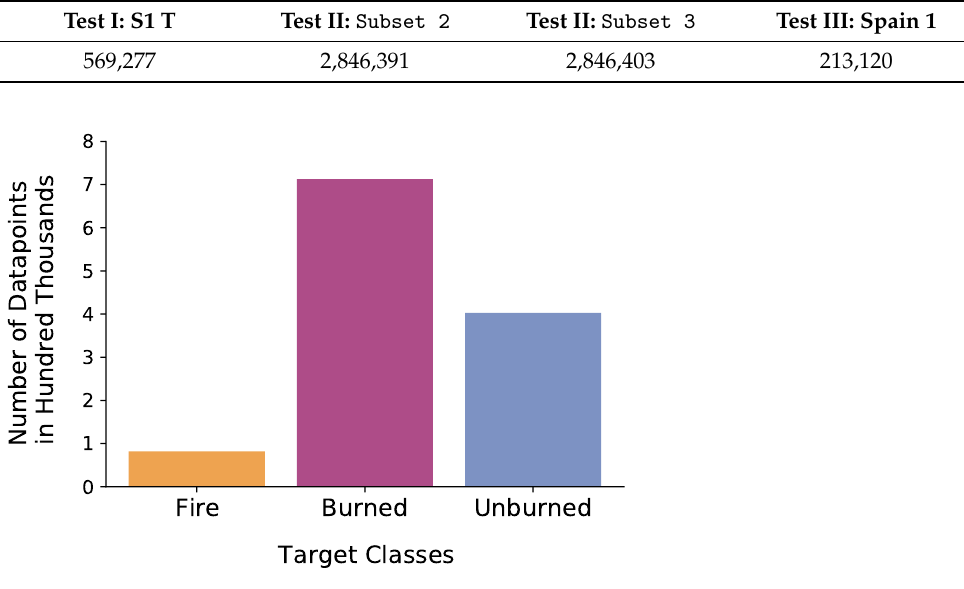
Figure 7. Distribution of data points of an undersampled subset ( Uset 1 ) per target class after balancing with a slightly lesser imbalance than the